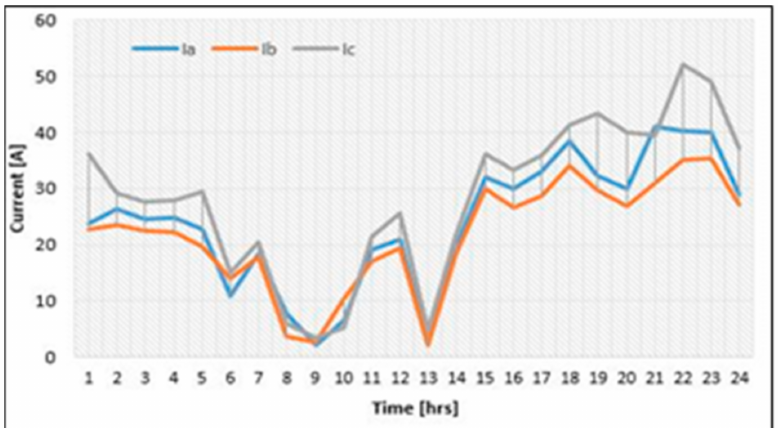
Figure 20. The aggregated phase currents at the level of the CCP obtained with the proposed methodology, P-PLB